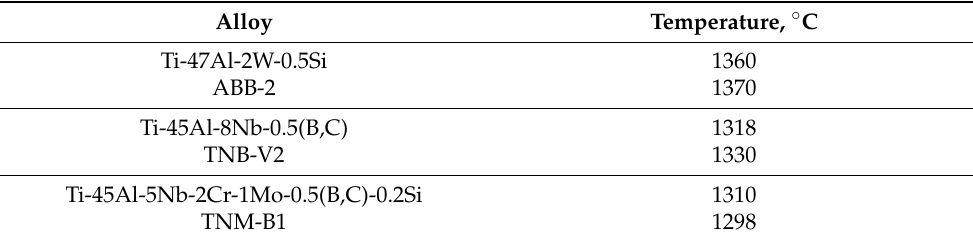
Table 2. Phase transition end temperatures α + γ → α of produced and reference